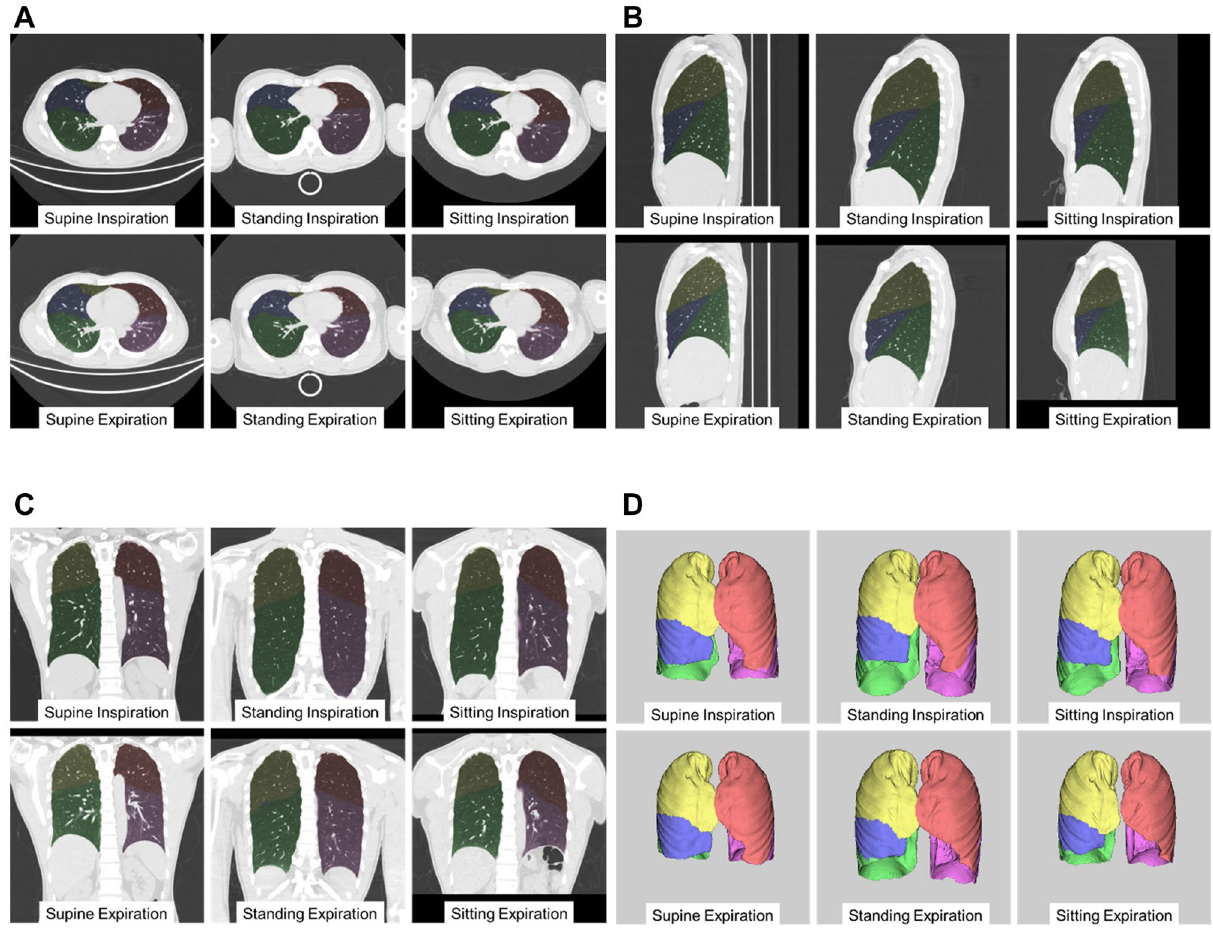
Figure 2. Representative segmentation and inspiratory/expiratory lung/lobe volume measurement in a 39-year- old male subject: axial ( A ), sagittal ( B ), and coronal ( C ) images, and volume rendering images ( D ) acquired in the supine, standing, and sitting positions. Yellow is the right upper lobe, blue is the right middle lobe, green is the right lower lobe, pink is the left upper lobe, and purple is the left lower were found in the average inspiratory volumes of the total lung, right lung, left lung, and all lobes between stand- ing and sitting positions (Table 2). proportional volumes of each lung and each lobe relative to the total lung volume in supine, standing, and sitting positions. In the inspiratory CT, the proportional volumes of the bilateral upper lobes and right middle lobe relative to the total lung volume were significantly lower in the standing and sitting positions than in the supine position, whereas the proportional volumes of the bilateral lower lobes were signifi- cantly higher in the standing position than in the supine position (all P < 0.001) (Table 3). Lung and lobe volume changes from expiration to inspiration on ct in supine, standing, and sitting positions. Volume changes of the total lung, right lung, left lung, right middle lobe, and bilateral lower lobe from expiration to inspiration in the standing and sitting positions were significantly higher than those in the supine position, whereas the bilateral upper lobe volume changes from expiration to inspiration were similar in the standing, sitting, and supine positions (Table 4). No significant differences were found in the all lung and lobe volume changes from expiration to inspiration between the standing and sitting positions (Table 4). Ratio of inspiratory lung/lobe volume to expiratory lung/lobe volume in supine, standing, and sitting positions. Differences in the ratio of inspiratory volume to expiratory volume in the total lung, right lung, right upper lobe, right lower lobe, left lung, left upper lobe, and left lower lobe between the supine and standing/sitting positions were less than 0.13, whereas the difference in the ratio of inspiratory volume to expiratory volume in the right middle lobe between the supine and standing/sitting positions were more than 0.29 (both P < 0.0001) (Table 5).